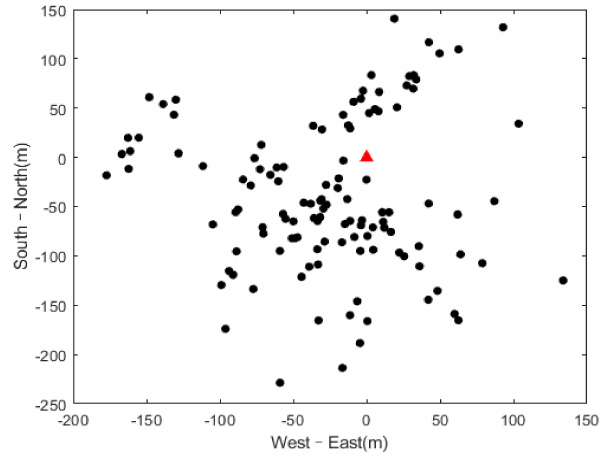
Figure 10. The positioning results of the new algorithm on the artificial trigger lightning return strokes detected by LFEDA in 2015 and 2017. The red triangle represents the actual position of the artificial trigger lightning device, and the black dots represent the points located by the new